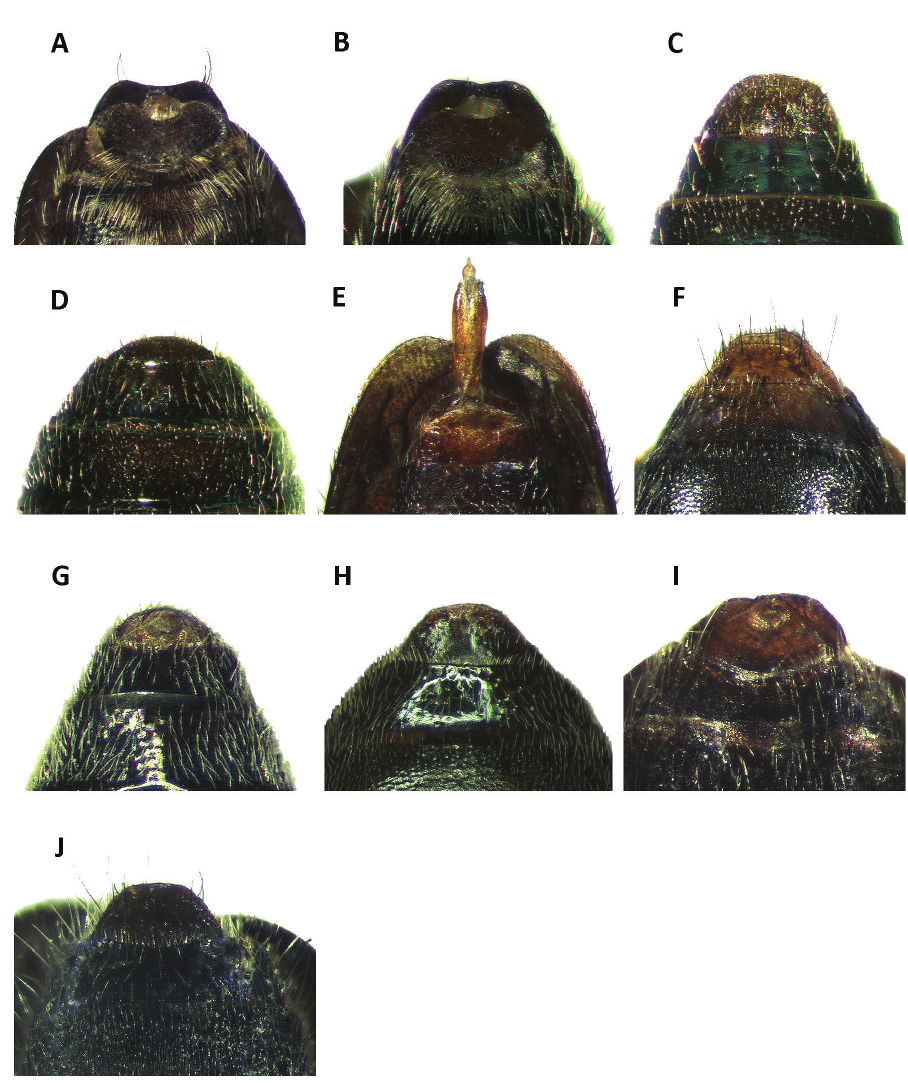
Figure 5. Pygidium of: A Neocallotillus elegans ( Callotillus elegans elegans ) male B N. elegans ( C. e. vafer ) male C N. elegans ( C. e. elegans ) female D N. elegans ( C. e. vafer ) female E N. intricatus ( C. intricatus ) male F N. intricatus ( C. intricatus ) female G Callotillus bahamensis male H C. bahamensis female I C. eburneocinctus male J C. eburneocinctus